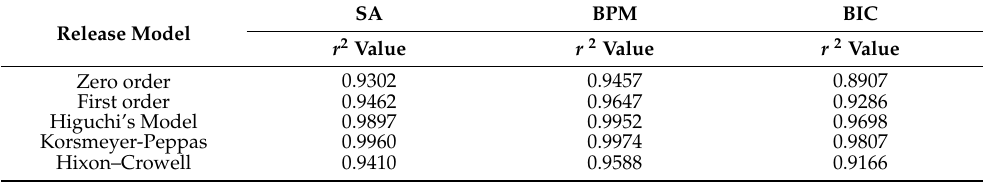
Table 1. Correlation coefficients calculated by fitting in vitro data to different release models.